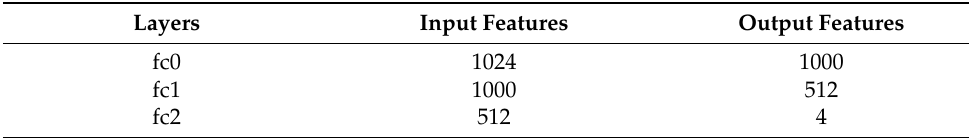
Table 1. Parameters of the DenseNet fully connected